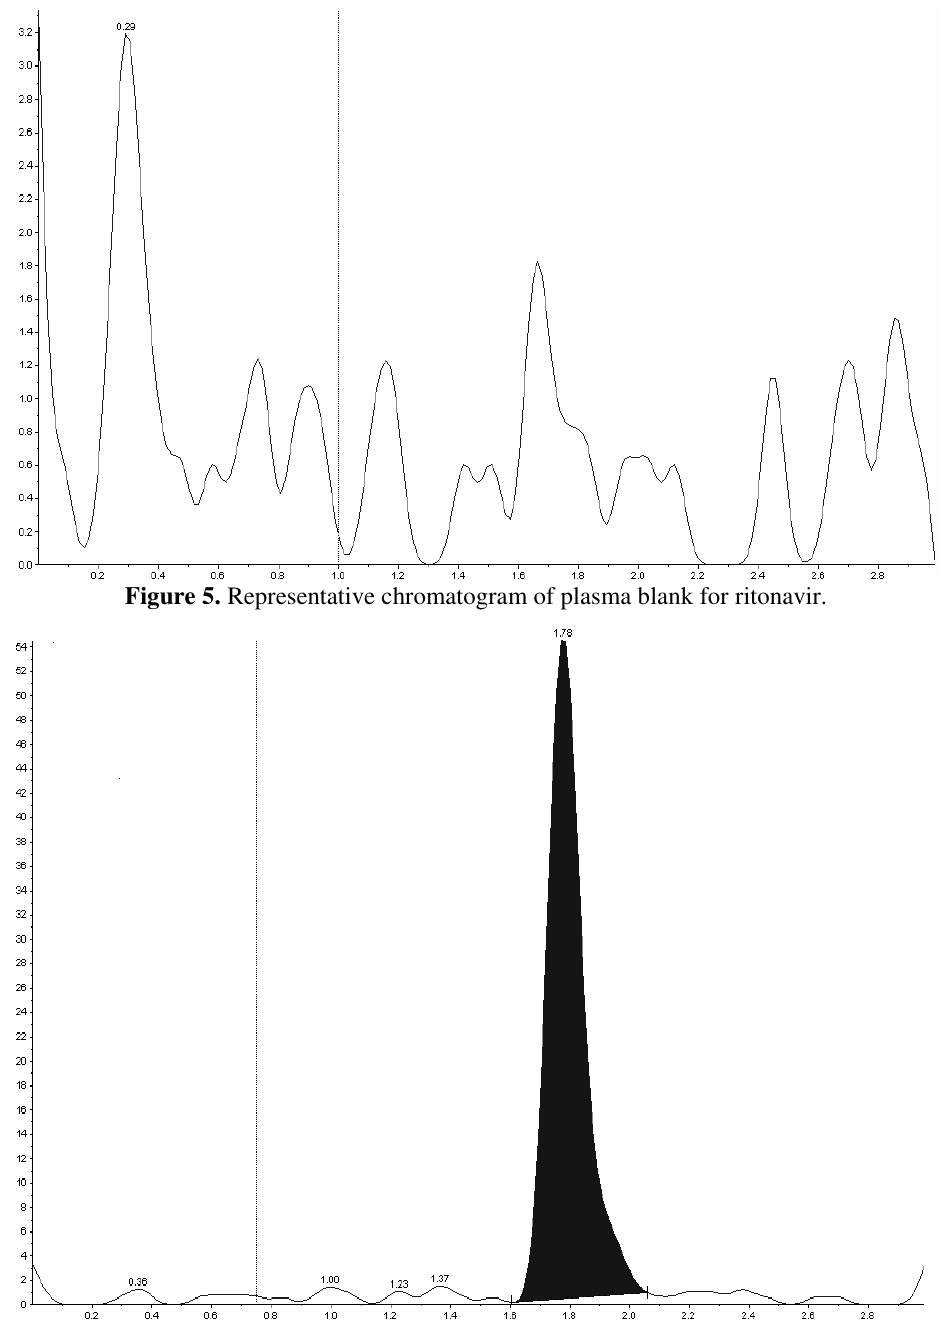
Figure 6. Representative chromatogram of plasma spiked with ritonavir at the lower limit of quantification (20.0 ng mL -1